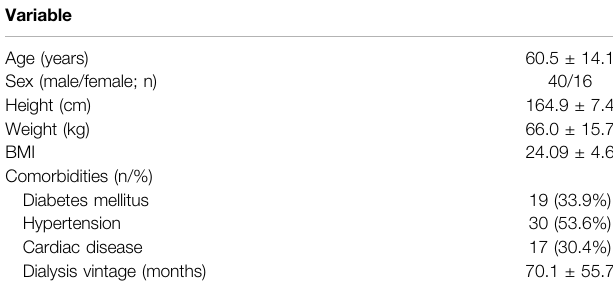
TABLE 1 | Patient characteristics (N =